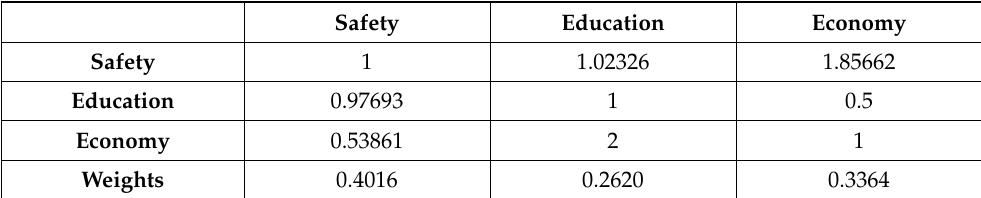
Table 22. Weights for the Criteria in the Team2